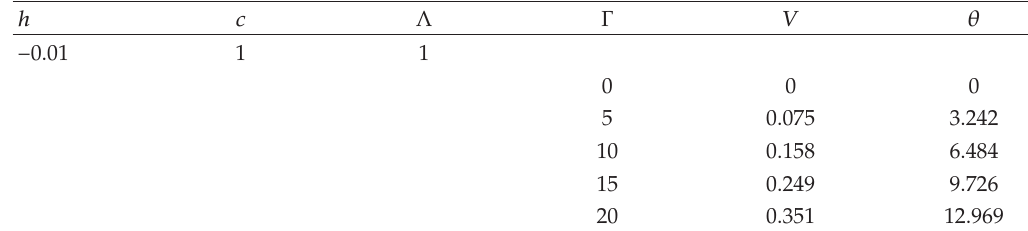
Table 3: Illustrating the variation of temperature with Γ